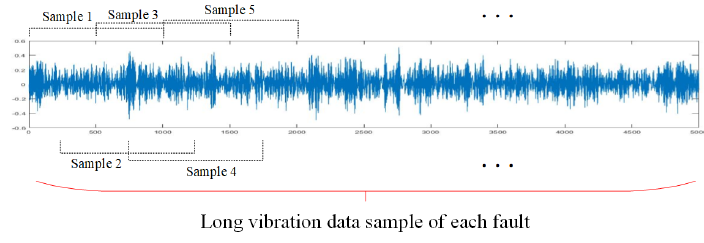
Figure 4. Schematic diagram of sample